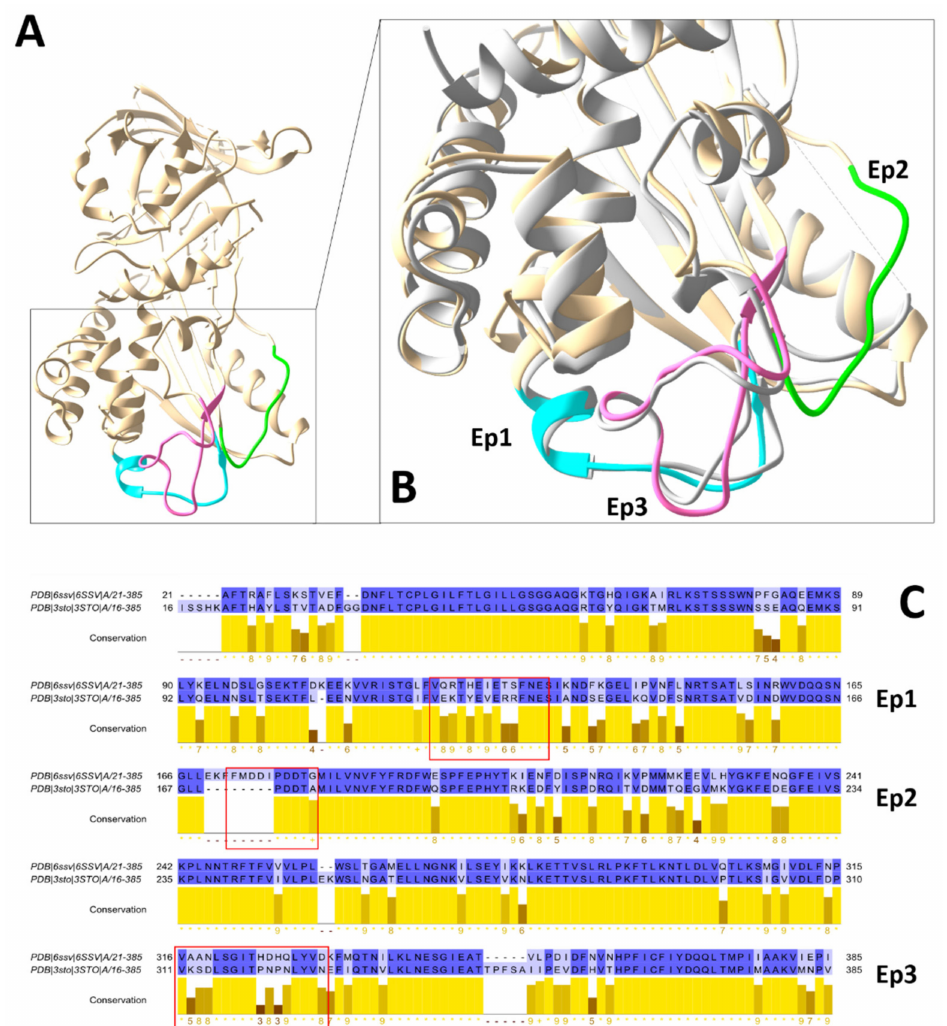
Figure 4. Representation of the three in silico identified epitopes, structure, and sequence comparison with S. hematobium homolog Serpin ShSPI. ( A ) SmSPI whole molecule representation. ( B ) SmSPI magnification of the three identified epitopes: Ep1 (cyan), Ep2 (green), and Ep3 (magenta) and structure comparison of the immunoreactive portion between SmSPI (6SSV—tan colored) and ShSPI (3STO—light grey colored). ( C ) Alignment of 6SSV and 3STO sequences. Percentage identity is color coded (darker blue: higher identity; lighter blue: lower identity). Conservation histograms of total alignment is reported in yellow. Alignment were performed with Jalview 2.11